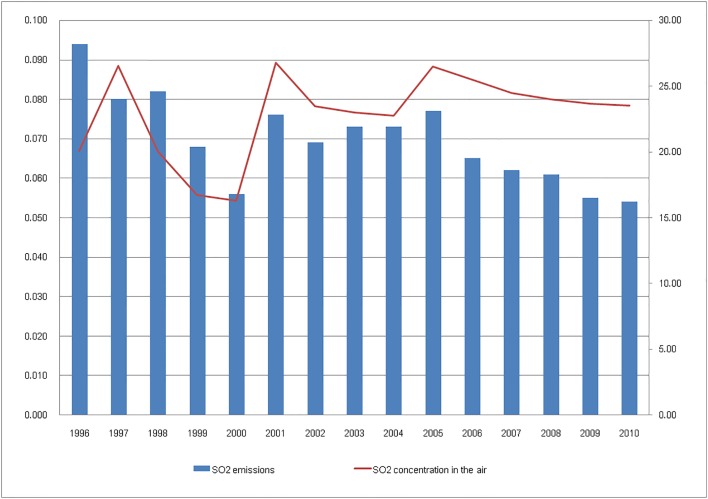
Trend diagram of SO2 emissions and its concentration in the air in Tianjin